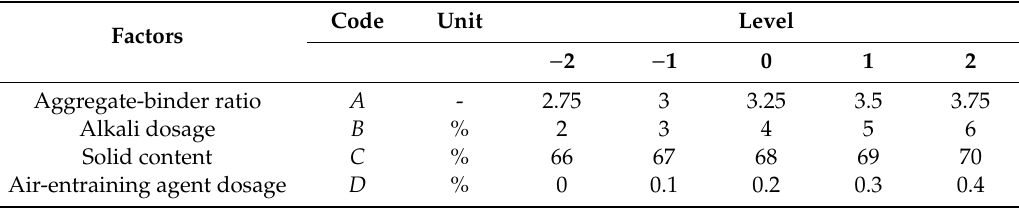
Table 2. Factors, numbers, levels, and units of the mix ratio design.